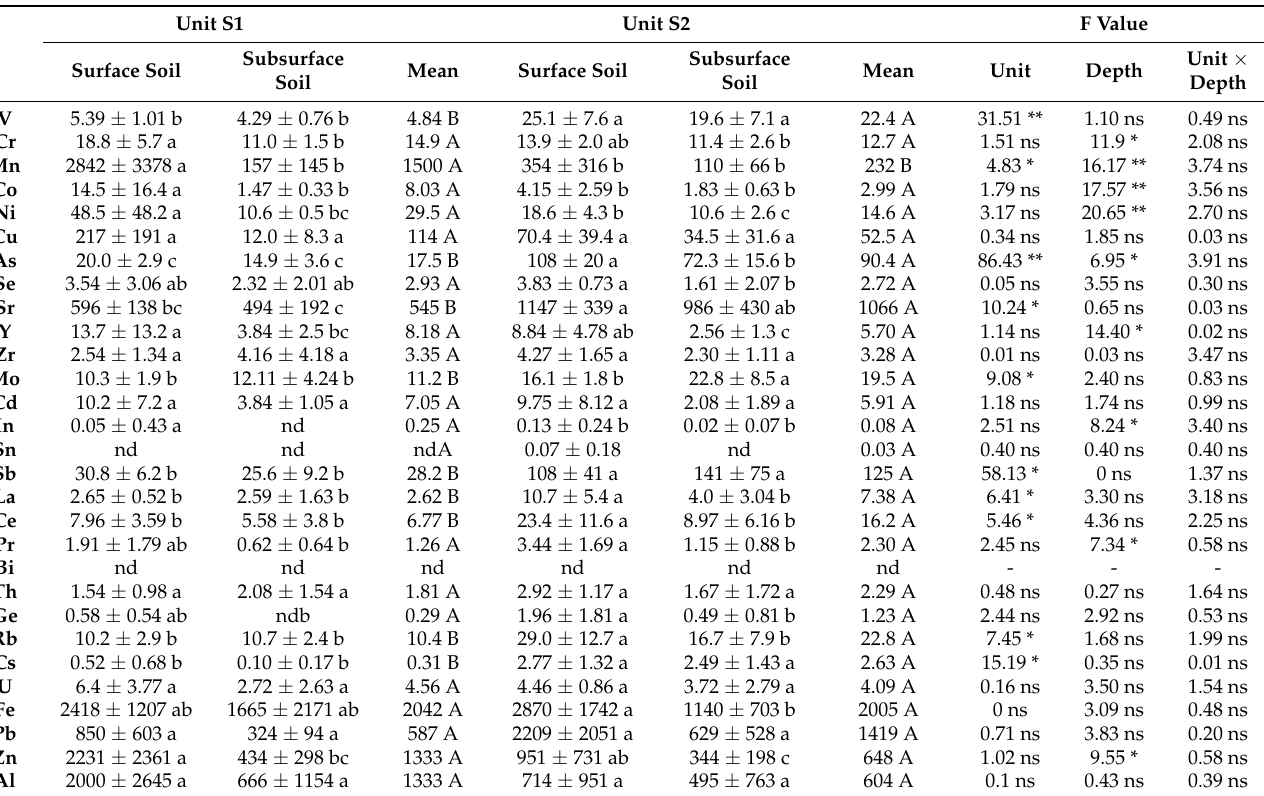
Table 4. Water-soluble concentrations of metals and REEs (mg kg − 1 ) in surface (0–15 cm) and subsurface (15–30 cm) soils from Units S1 and